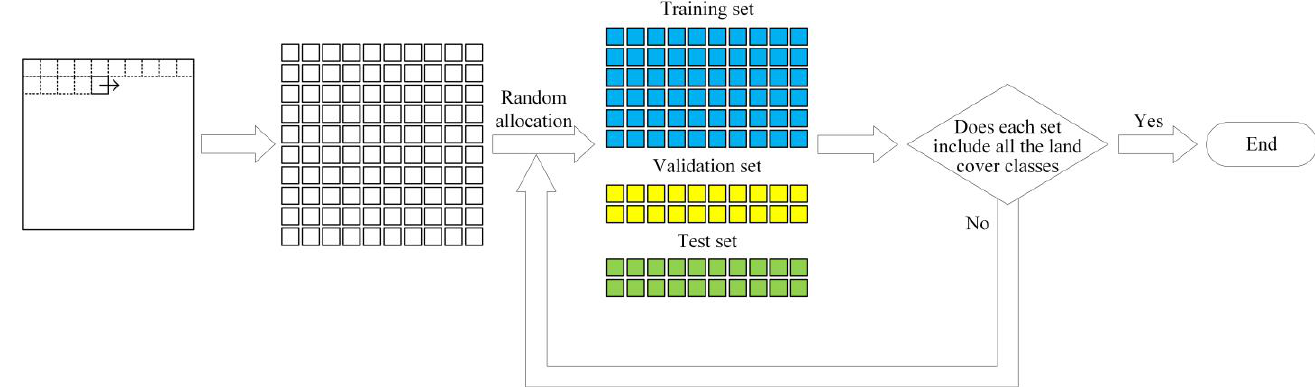
Figure 2. Dataset partition method.